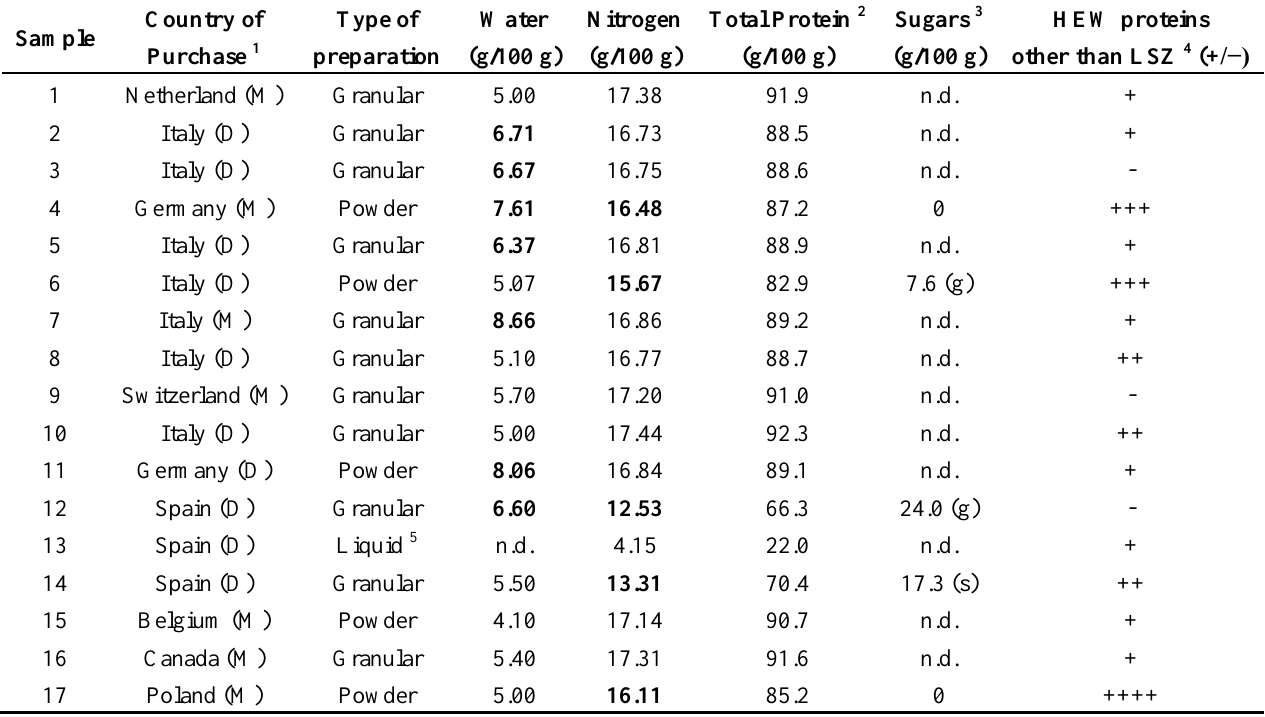
Table 1. Origin, type, and composition characteristics of the commercial lysozyme preparations. Values not complying with specifications of EU Reg. 231/2012 are in